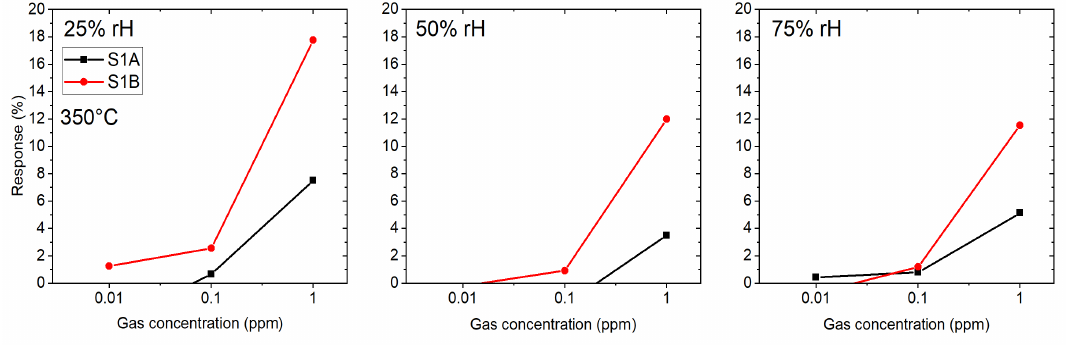
Figure 8. Response of SnO 2 nanowires-based membrane sensors towards H 2 S at 350 ◦ C: 1A and 1B — both of them prepared by the same